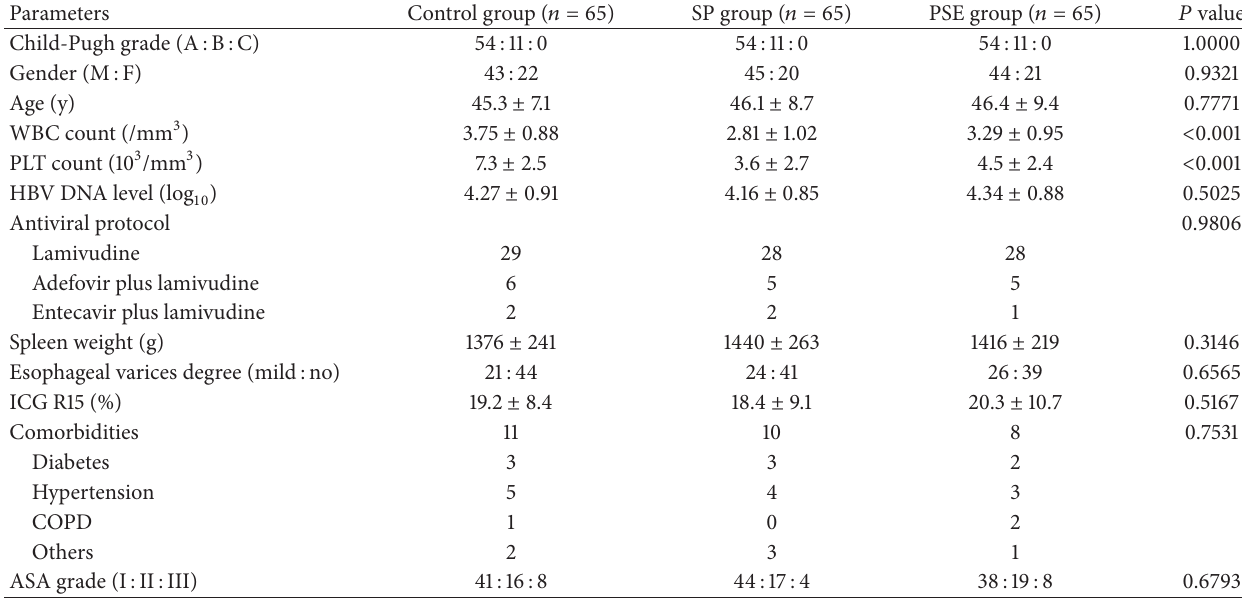
Table 1: Background characteristics of enrolled